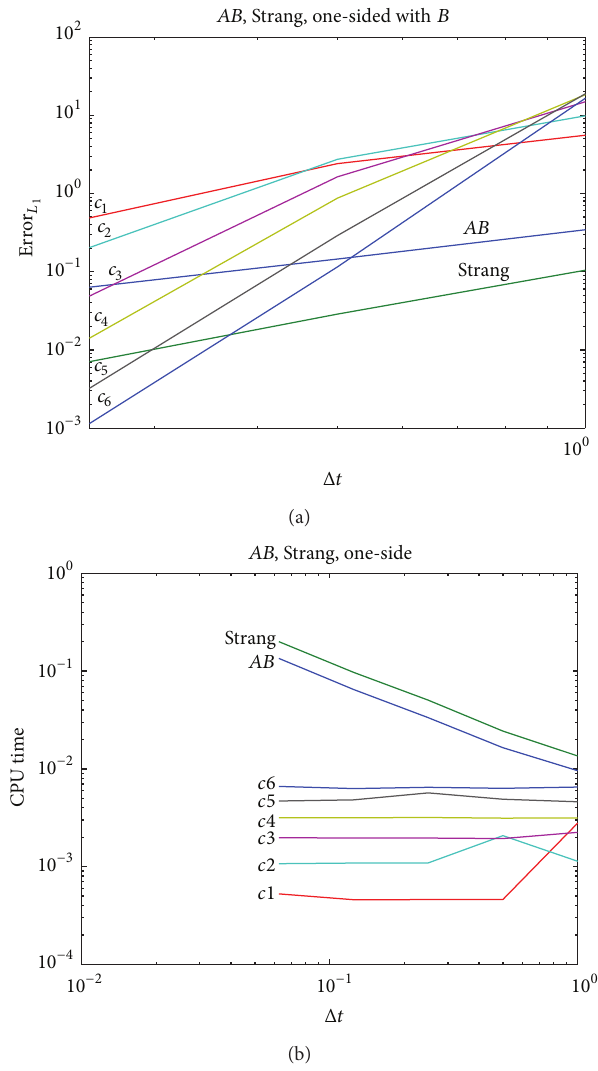
Figure 5: Numerical errors and CPU time of the standard splitting scheme and the iterative schemes with Zassenhaus formula, where we have at least 1,...,4 iterative